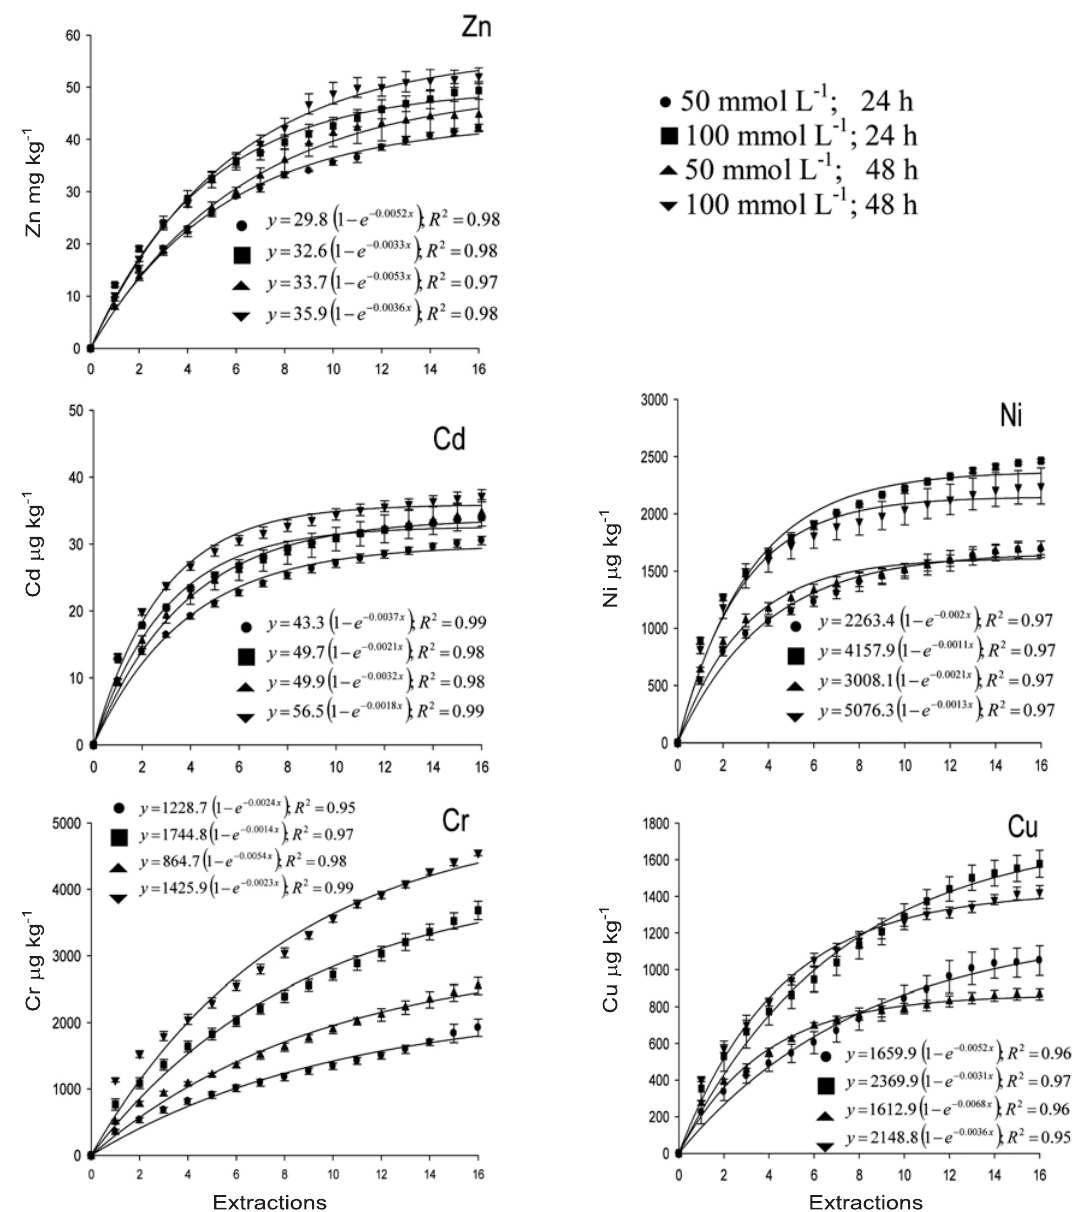
Figure 1. Successive extractions for 24 or 48 hours of Zn, Cd, Ni, Cr, and Cu from a sewage sludge-treated soil by organic acid mixtures (50 and 100 mmol L -1